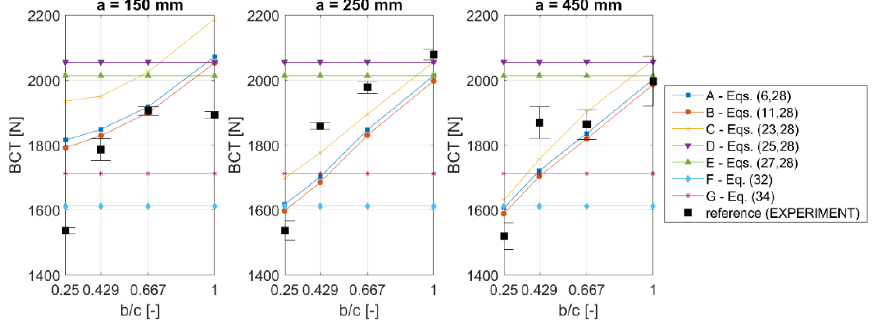
Figure 3. Box compression strength of simple flap boxes with different heights: 150 mm, 250 mm and 450 mm (for cases A – E 𝑘 = 0.5 and 𝑟 = 0.75; for case F 𝑘̂ = 2.028 and 𝑟 = 0.746; for case G 𝑘̌ = 5.874 and 𝑟 = 0.746). Table 3. Experimental data (dimensions and box compression strength) and computational errors